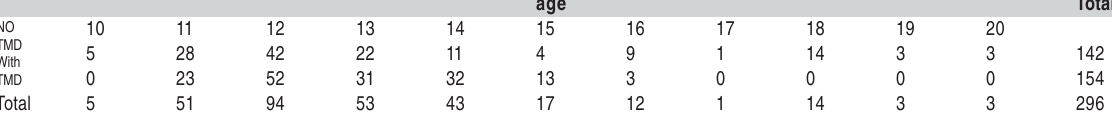
Table 2. Distribution of the participants by age and the presence of TMD.